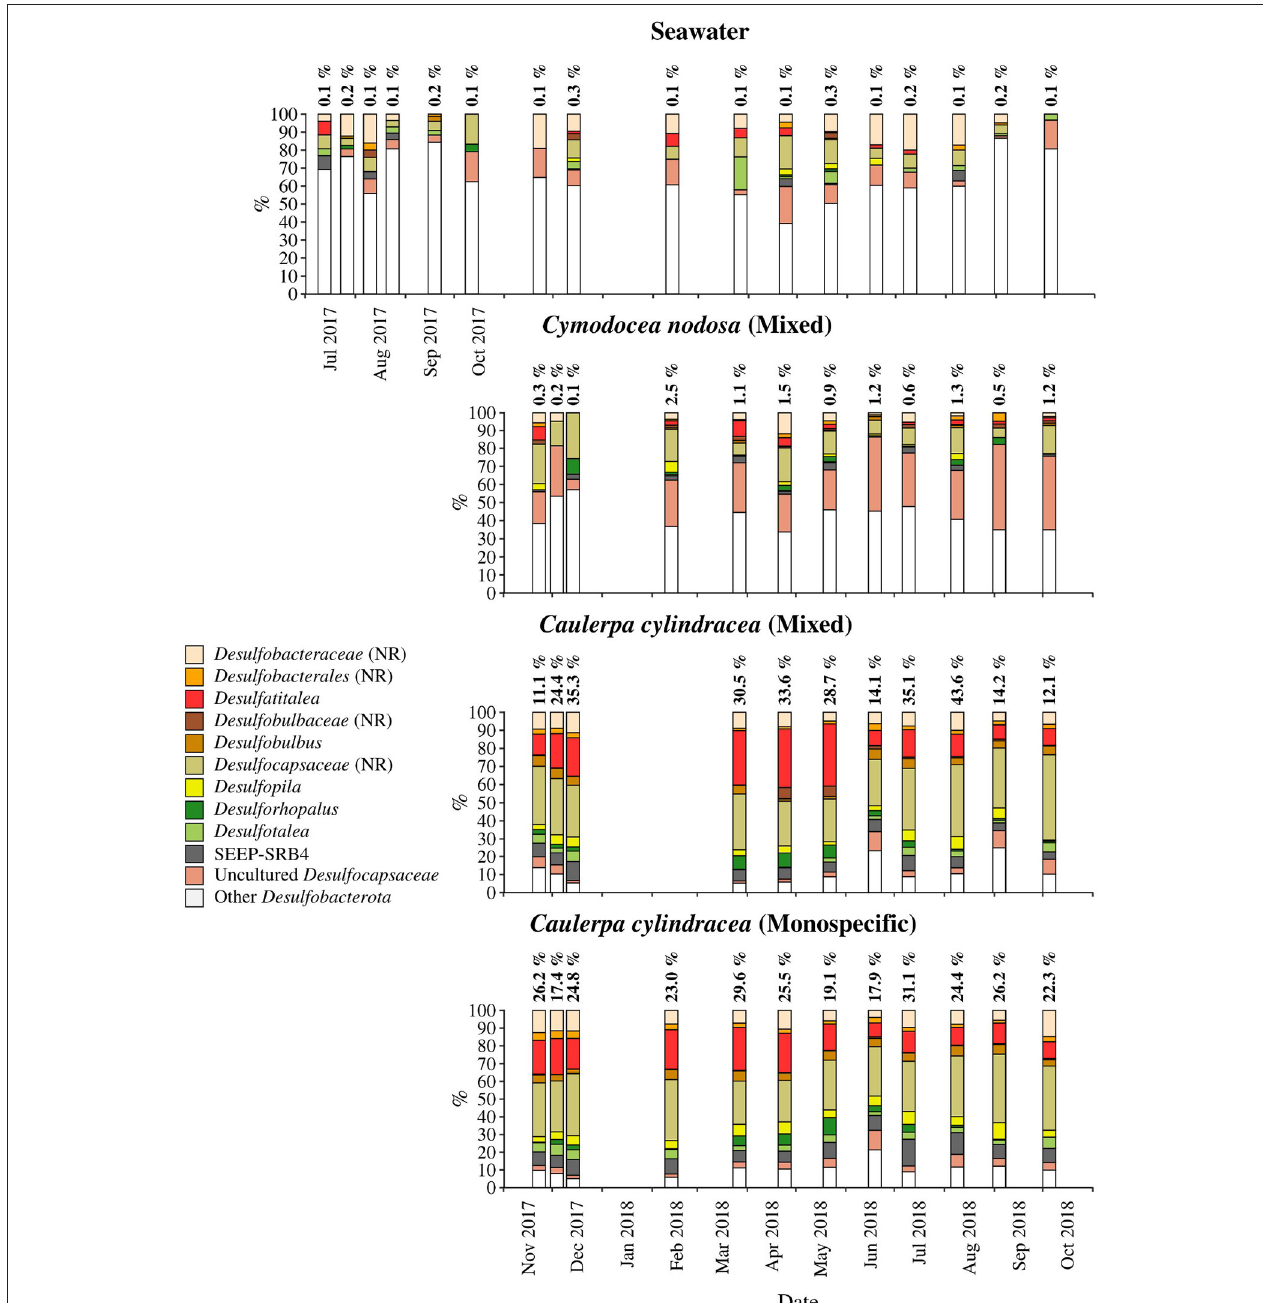
FIGURE 9 | Taxonomic classification and relative contribution of the most abundant ( ≥ 1%) sequences within the Desulfobacterota on the surfaces of the macrophytes C. nodosa (mixed settlement) and C. cylindracea (mixed and monospecific settlement) and in the ambient seawater. The proportion of sequences classified as Desulfobacterota in the total bacterial and archaeal community is given above the corresponding bar. NR, no relative (sequences without known relatives within the corresponding